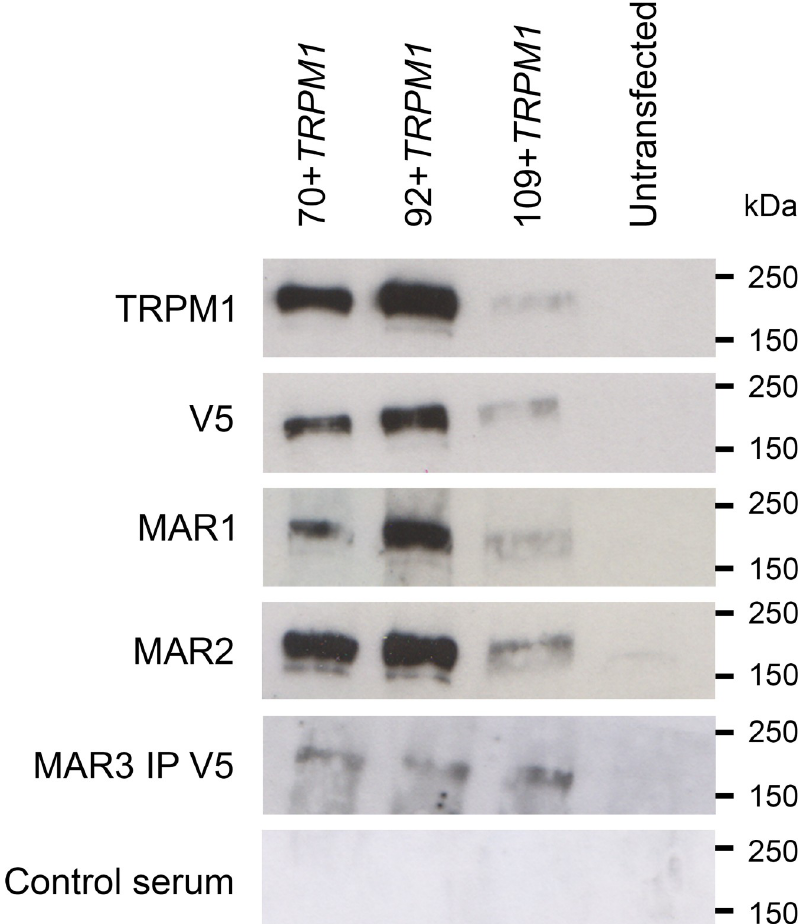
Fig 3. Western blot analysis of TRPM1 isoforms with MAR sera. Immuno blots of COS-7 cells transfected with the three isoforms of TRPM1 using several antibodies: an anti-TRPM1 antibody, an anti-V5 antibody, MAR1 and MAR2 sera, MAR3 sera after immunoprecipitation using an anti-V5 antibody and a control serum. All antibodies recognized the 70+ TRPM1 , 92+ TRPM1 and 109+ TRPM1 isoforms (~180-200kDa). No signal was obtained with protein extracted from untransfected